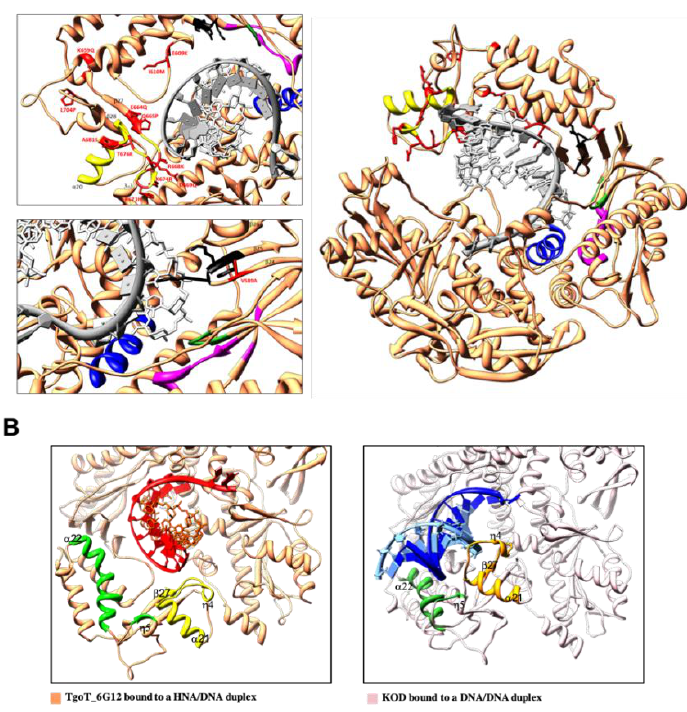
Figure 6. Analysis of TgoT_6G12 binding mode to the HNA-DNA duplex using MD simulations. ( A ) In the right panel, an overview of the closed complex of TgoT_6G12 polymerase (in coral) with an HNA-DNA heteroduplex. The template DNA strand is represented as a dark gray ribbon with its associated sugar / base backbone shown as a tube. The primer HNA strand is represented in light gray with atoms and bonds. On the left panel, a blow up of two regions of the right panel, but in a different orientation. Mutated residues that confer HNA binding and synthesis capacity are shown and labeled in red. The region from residues 664 to 688, which interacts with the template strand is labeled in yellow. Representative motifs are labeled. The A-motif (DxxSLYPSI), in addition to E578 and E580, is colored in magenta. The C-motif (DTDG) of the palm domain and the Kx3NSxYGx2G B-motif in the finger domain are colored in green and dark blue, respectively. The KKKY motif of the thumb domain, is labeled in dark. ( B ) Conformational changes observed between the ternary structure of TgoT_6G12 bound to a HNA-DNA duplex, on the left, and the ternary structure of KOD bound to a DNA-DNA duplex, on the right. The template strands of TgoT_6G12 and KOD are labeled in red and dark blue, respectively. The primer strands of TgoT_6G12 and KOD are labeled in orange and light blue, respectively. The region from amino acids 664 to 688 interacts with the template strand in TgoT_6G12 (yellow) and with the primer strand in KOD (orange). Helix η 5 and α helix 22 are labeled in light and dark green, respectively, in TgoT_6G12 and in KOD ternary complexes. While these two helices are stabilizing the template strand in the KOD ternary structure, they are shifted away from the HNA-DNA duplex in TgoT_6G12 ternary